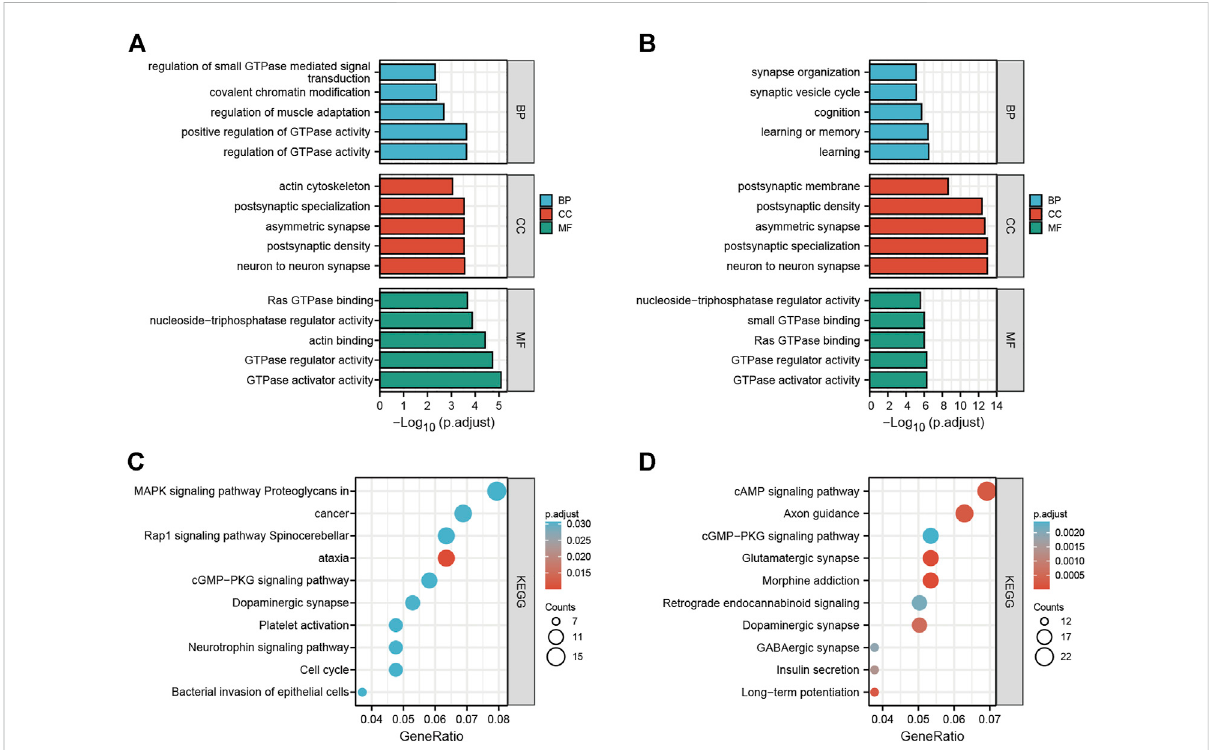
FIGURE 2 GO and KEGG pathway analyses of differentially expressed circRNAs. (A) Top fi ve enriched GO terns for the parental genes of upregulated circRNAs. (B) Top fi veenrichedGOternsfortheparentalgenesofdownregulatedcircRNAs. (C) Top10KEGGtermsofparentalgenesofupregulated circRNAs. (D) Top 10 KEGG terms of parental genes of downregulated circRNAs. GO, Gene Ontology; KEGG, Kyoto Encyclopedia of Genes and Genomes; circRNAs, circular